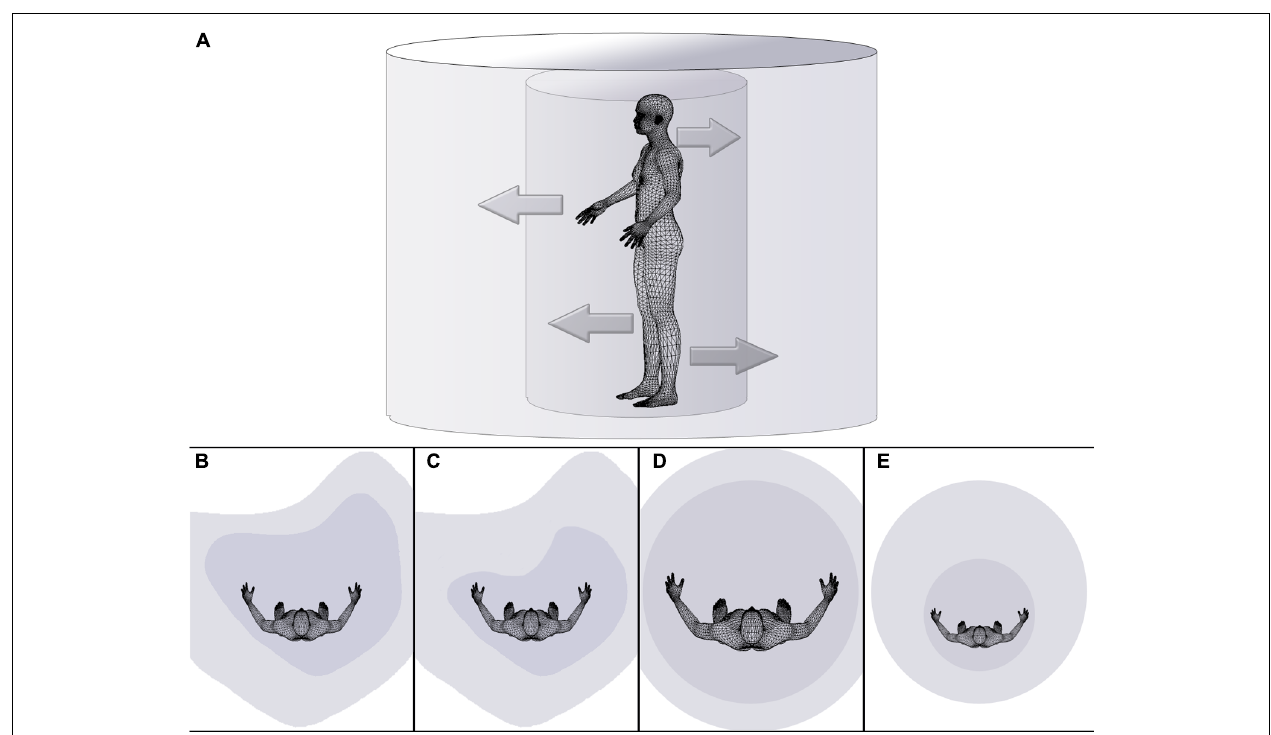
from the inner to the outer cylinder symbolize the dependency of the extent or size of extrapersonal space on the state/size of peripersonal space. Distorted space perception is illustrated for healthy right-handers (B) , individuals affected by hemispatial neglect (C) , individuals effected by eating disorders on the example of anorexia nervosa (D) , and individuals experiencing a small body illusion (e.g., van der Hoort etal., 2011; Banakou etal., 2013) (E)